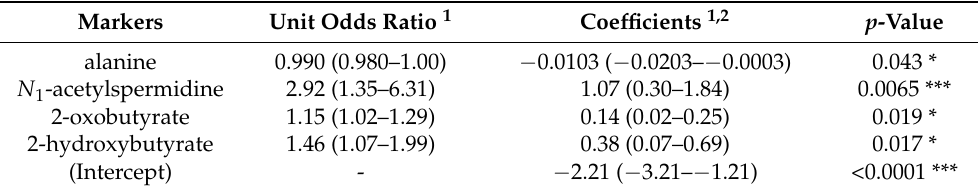
Table 2. Parameters of the multiple logistic regression (MLR)